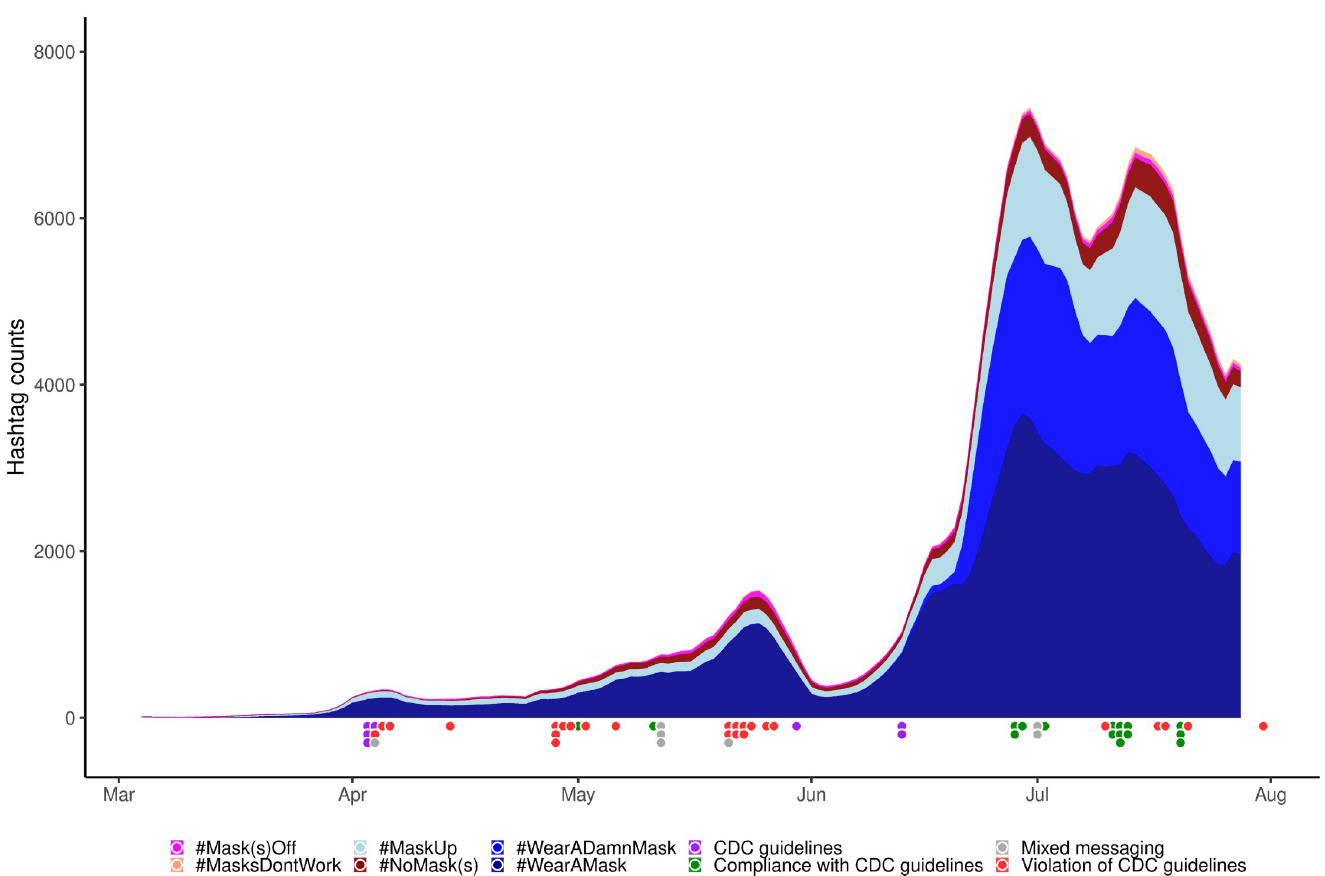
Fig 3. Trends of top 3 anti- and pro-mask hashtags on Twitter. This figure shows the 7-day moving averages of the three most popular anti-mask hashtags (#NoMask(s), #Mask(s)Off, #MasksDontWork) and pro-mask hashtags #WearAMask, #WearADamnMask, #MaskUp) in the period of interest in a stacked area